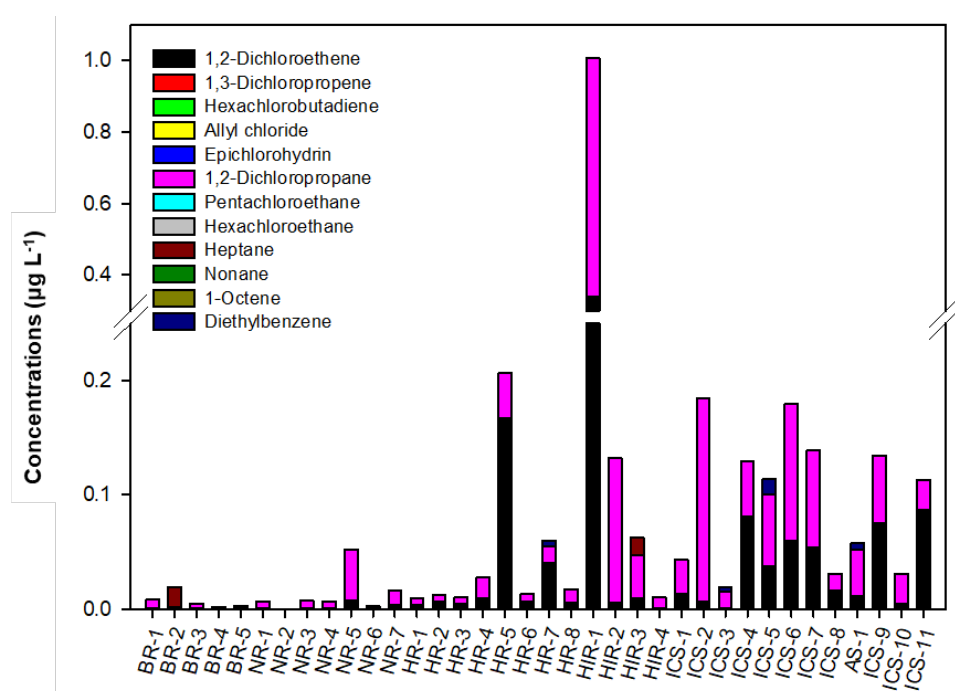
Figure 3. Average concentration of VOCs at different sampling sites. 1,2-dichloroethene includes cis- and trans-1,2-dichloroethene; 1,3-dichloropropene includes cis- and trans-1,3-dichloropropene; heptane includes 2-methylhexane isomer; and diethylbenzene includes 1,2-, 1,3-, and 1,4-diethylbenzene isomers.